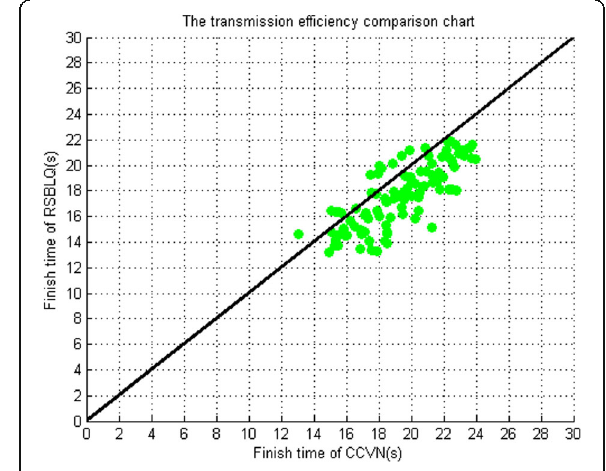
Fig. 12 The transmission efficiency comparison with